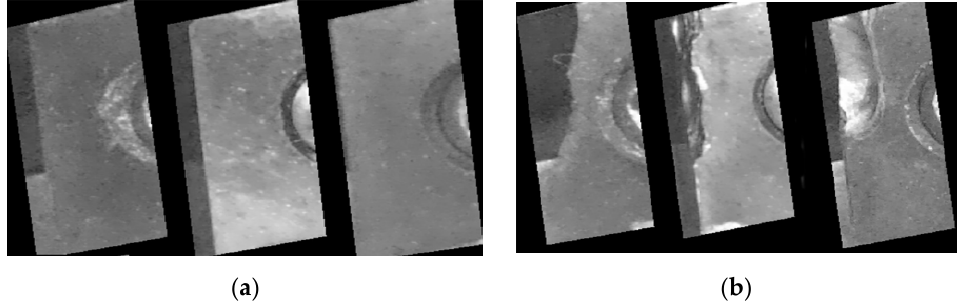
Figure 3. Detected portion of cutting edges: ( a ) serviceable edges and ( b ) edges with high wear.